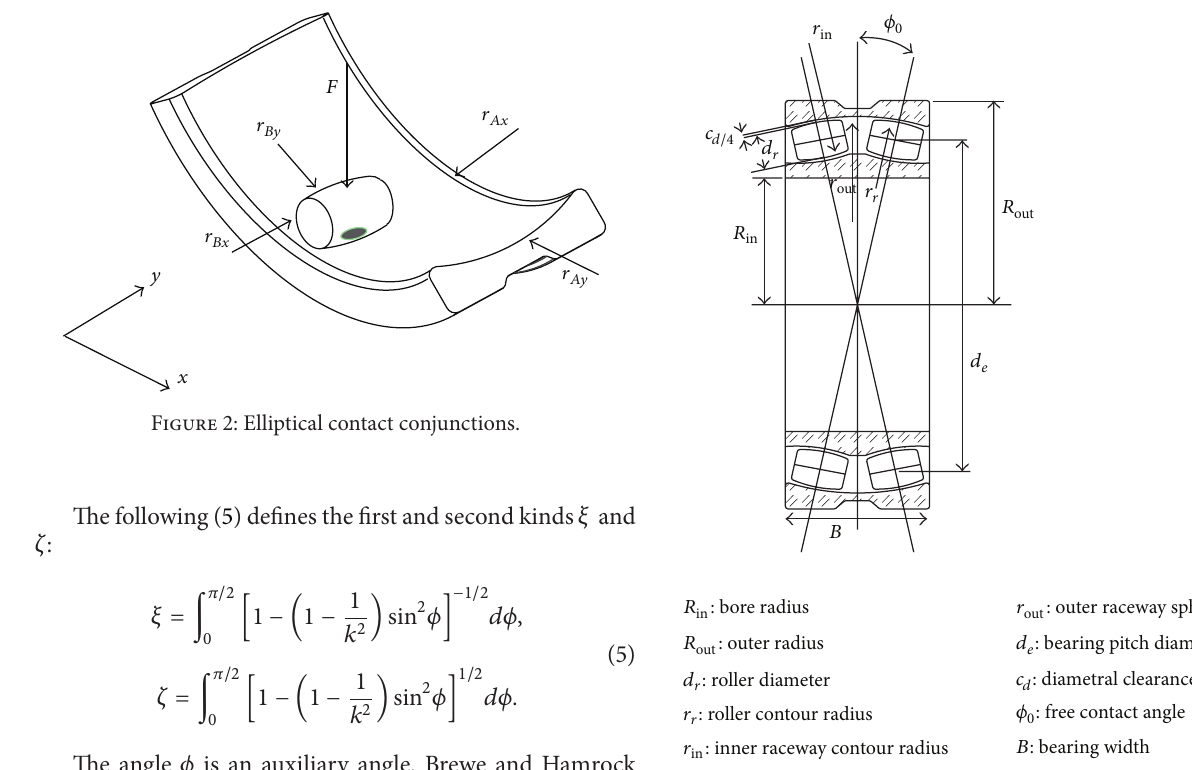
Figure 3: Dimension of spherical roller